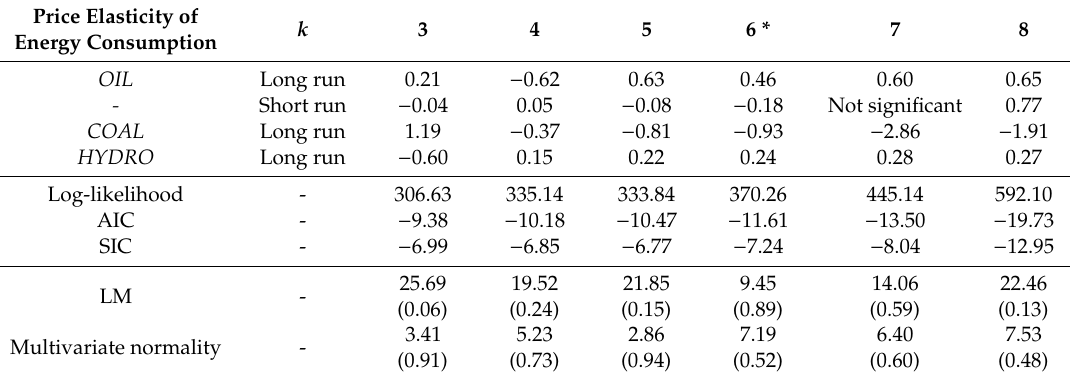
Table 5. Specification experiments for Johansen cointegration test using di ff erent lag